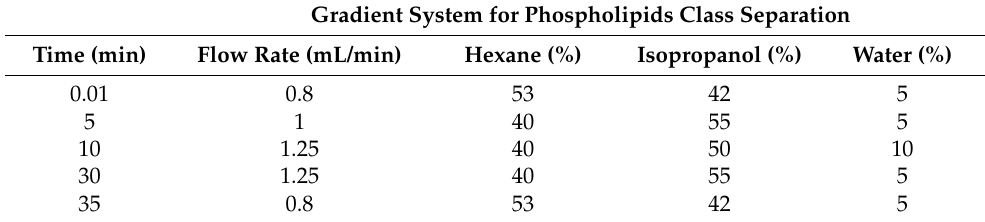
Table 2. Solvent gradient system used for phospholipids class HPLC